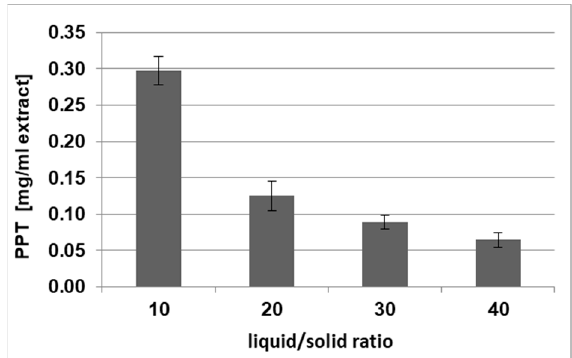
Figure 3. Effect of the liquid-to-solid ratio on the PPT concentration per volume of J. virginiana extracts. Variable parameter—liquid-to-solid ratio (LSR, v / w ); constant parameters—process duration (5 h), previously selected solvent (ethyl acetate) and room temperature (20 °C).